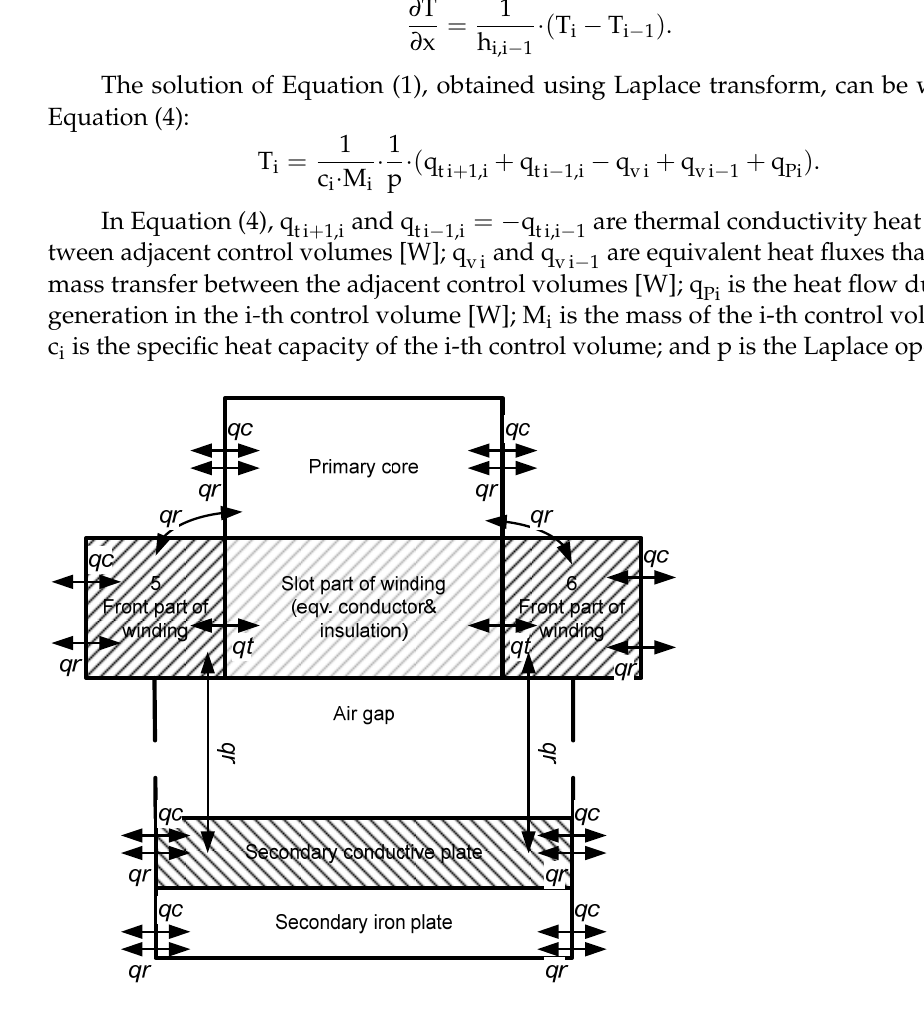
Figure 2. Thermal model of the LIM—cross section.